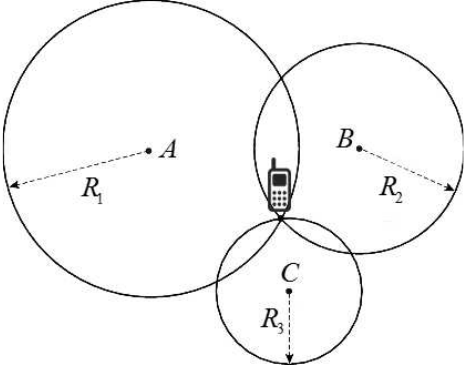
Figure 5. Positioning based on